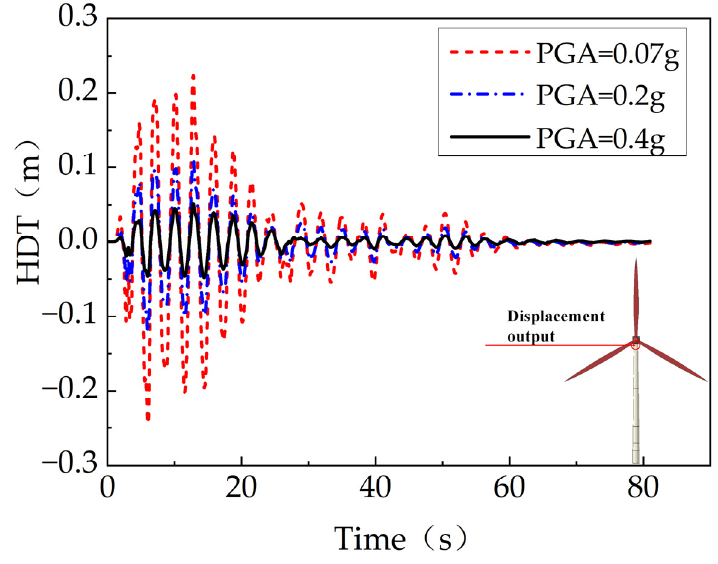
Figure 8. El Centro earthquake.